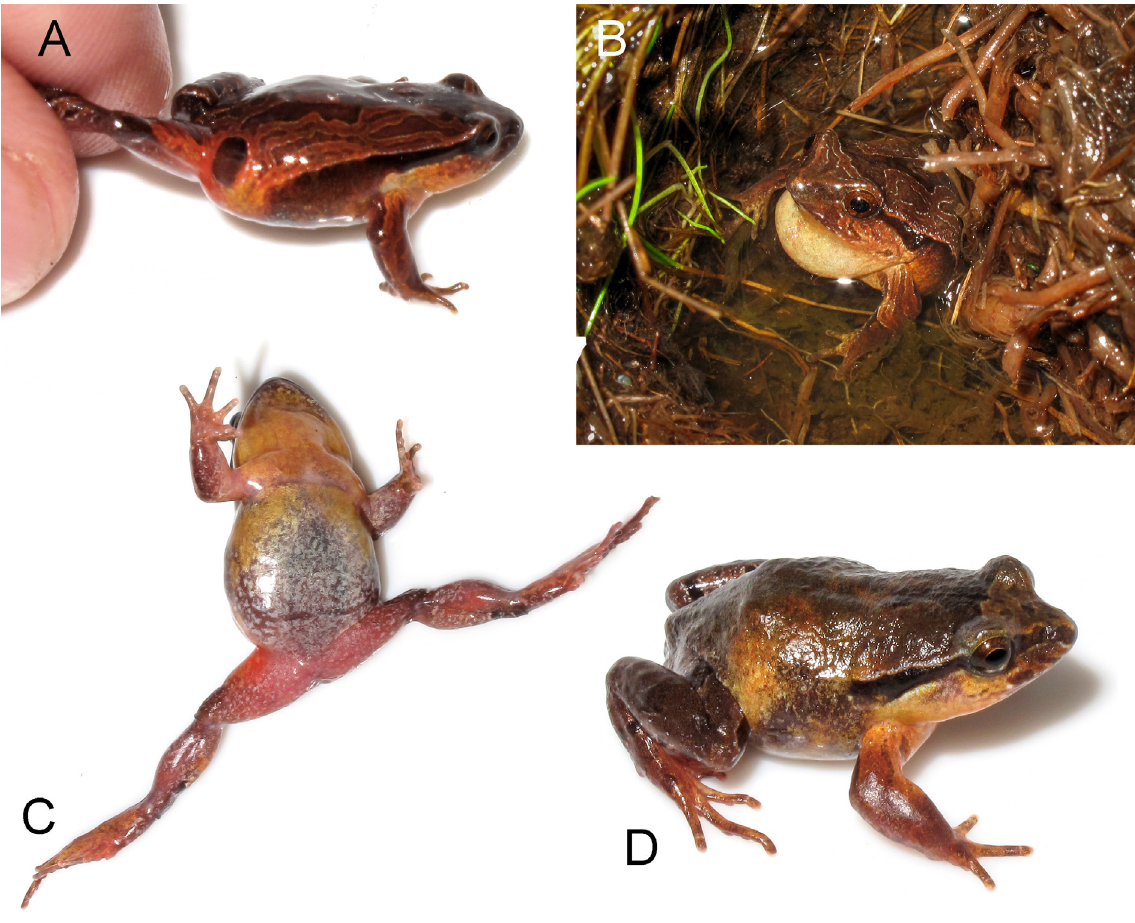
Fig. 3. Color in live paratypes of Physalaemus araxa sp. nov. A . ZUEC-AMP 24119 (paratype), evidencing the color of inguinal region. B . ZUEC-AMP 24120 (paratype), in an upright posture with vocal sac slightly inflated, photographed in situ; notice the contrast of the yellow vocal sac with the background. C–D . ZUEC-AMP 24098 (paratype), evidencing ventral and dorsolateral colors; notice the distribution of yellow pigmentation ventrally and